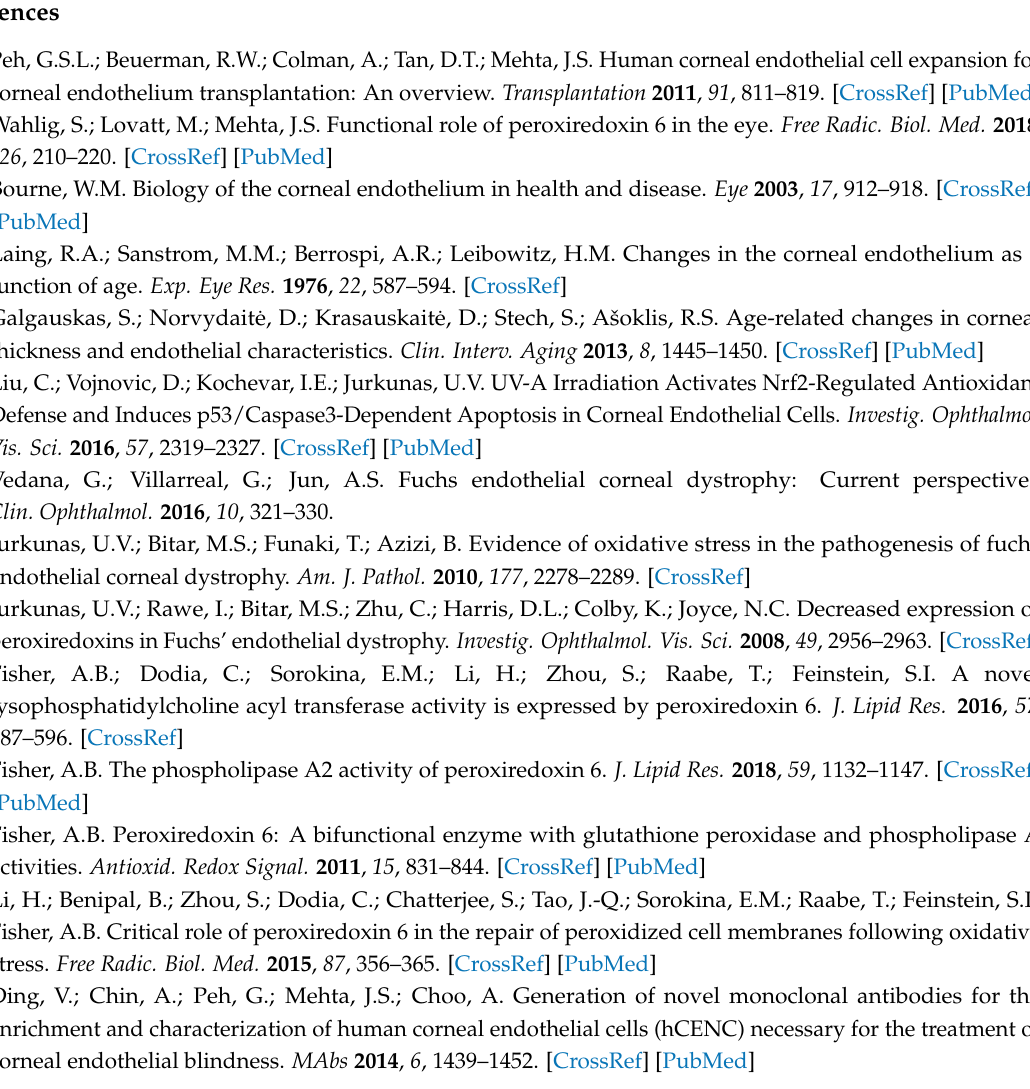
Figure S1. Cytoplasmic and plasma membrane (PM) proteins were purified from A549 and B4G12 cell lines left untreated ( − ) or treated (+) for 3 h with tBHP. Figure S2. Menadione disrupts mitochondrial membrane potential. B4G12 cells were treated with the indicated compounds for the desired